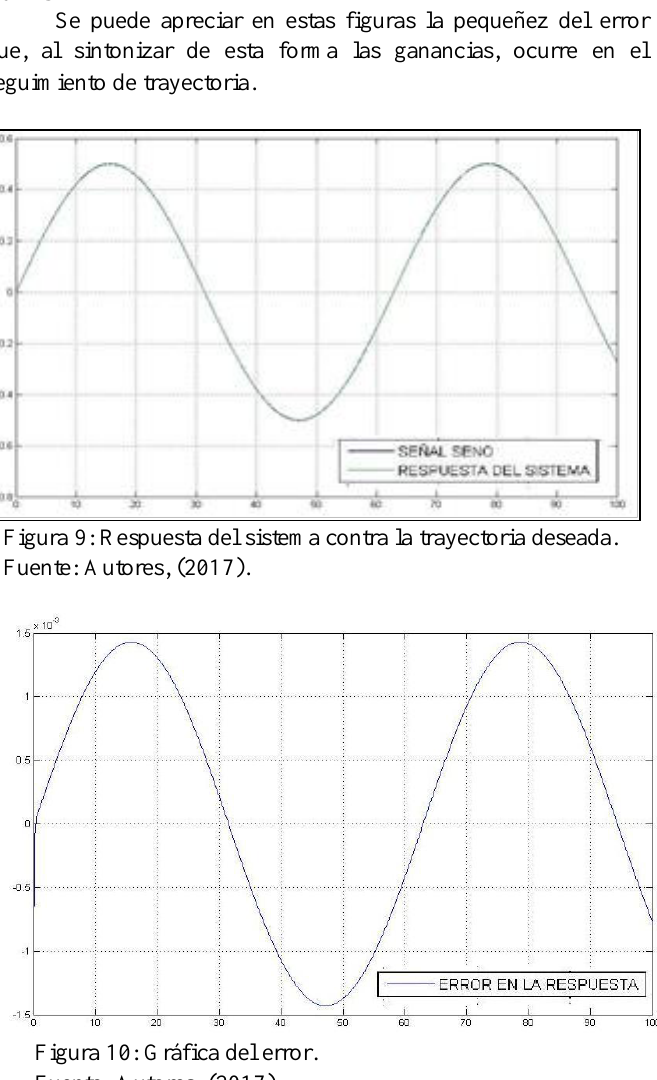
Figura 10: Gráfica del error. Fuente: Autores,